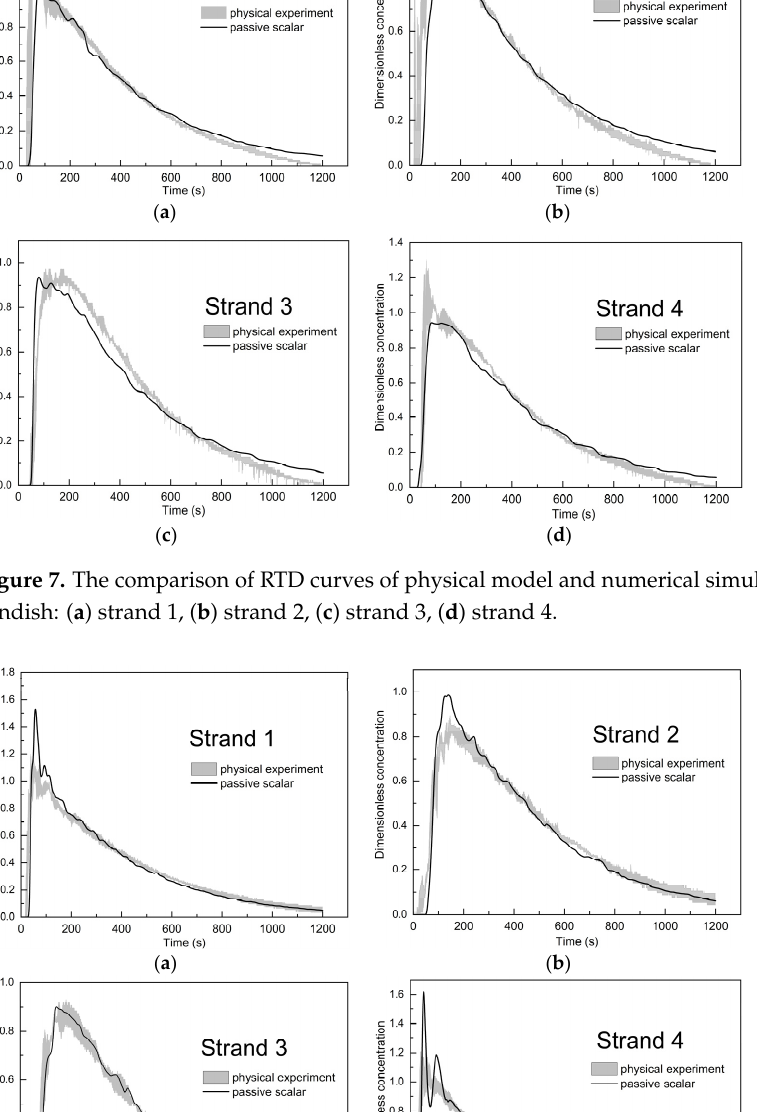
Figure 6. Comparison of ink diffusion photographs in water model and isosurface ( ω = 10 − 5 ) figures of numerical simulation results of u-shaped weir tundish: ( a ) ink diffusion photographs, ( b ) isosur- face figures.